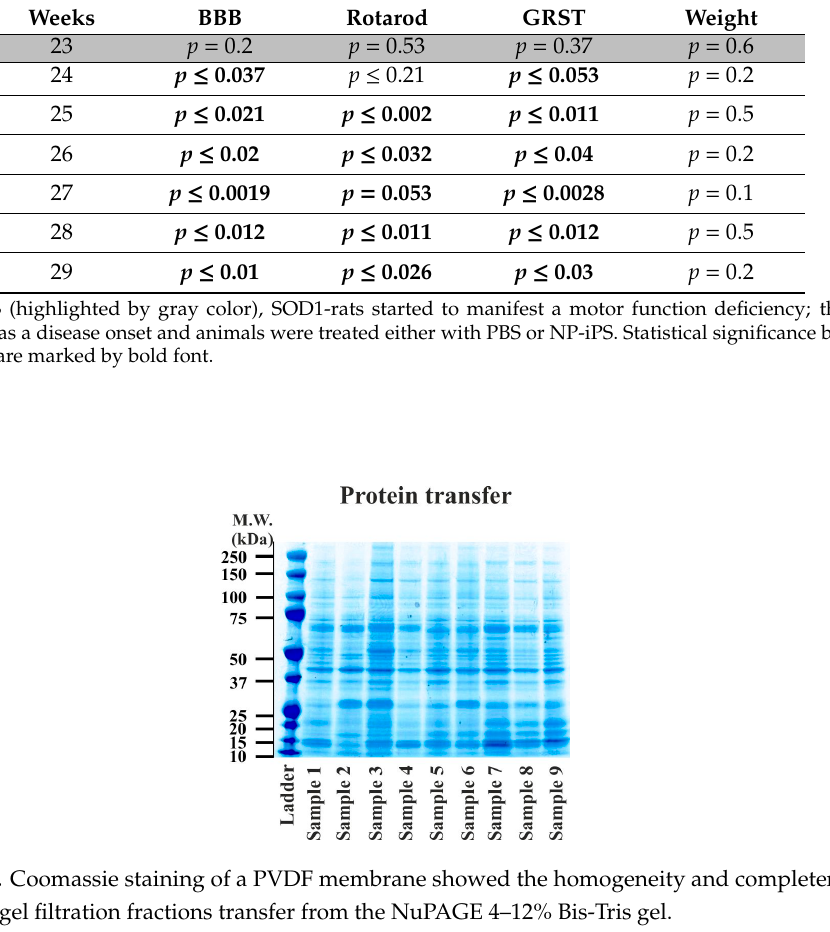
Table A2. Statistical analysis of behavioral tests between symptomatically NP-iPS-treated group of animals and vehicle-treated littermates.